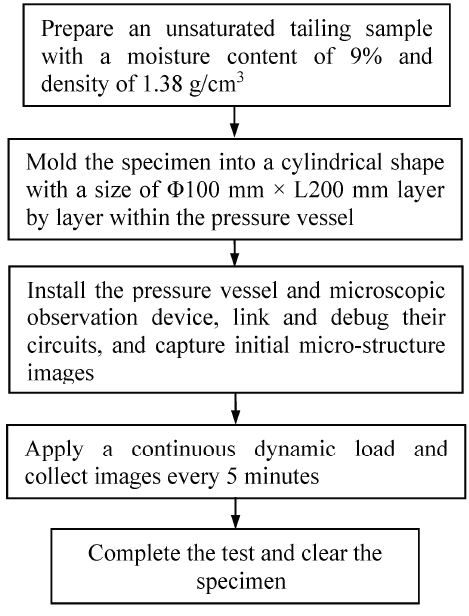
Figure 4. Experimental procedure for each tailing